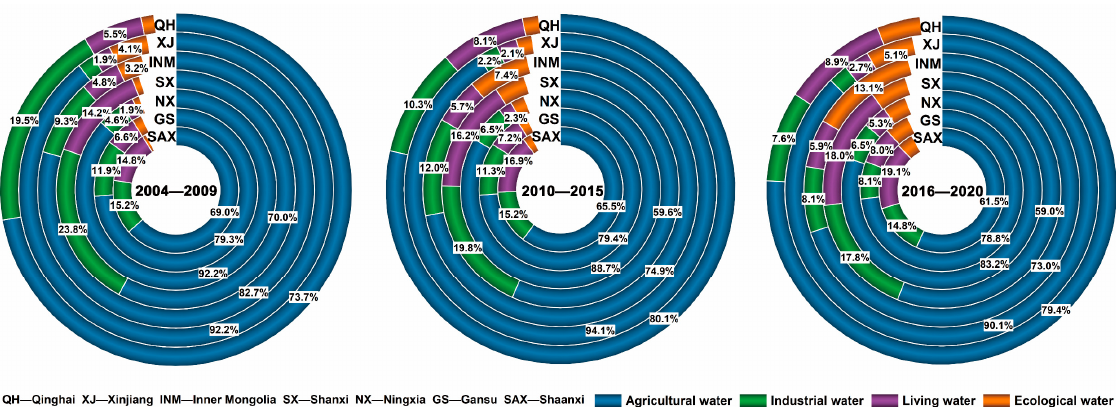
Figure 4. Characteristics of water-use structure in Northwest China.